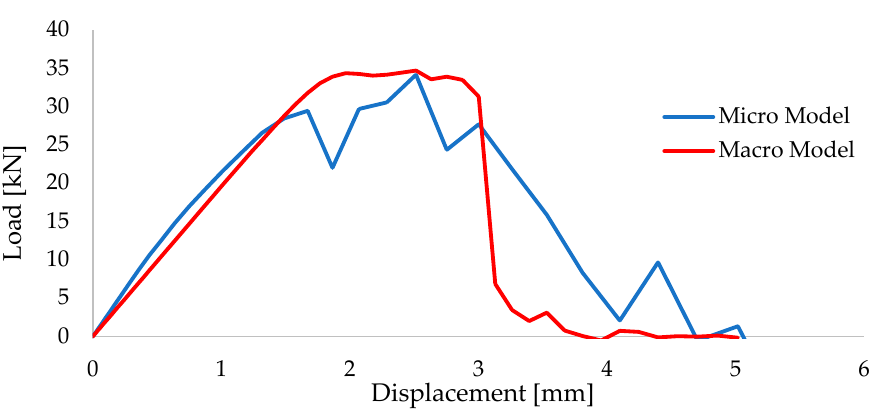
Figure 16. Damage distribution on the ( a ) micro-modeled wallet and ( b ) macro-modeled wallet.